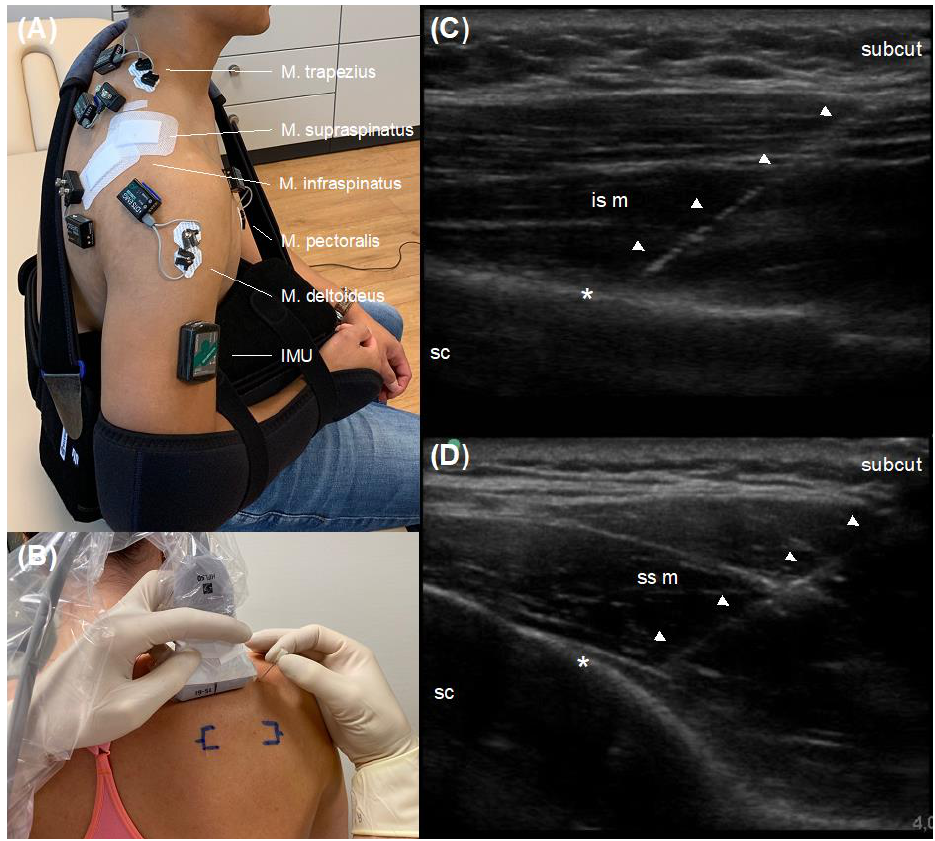
Figure 2. Placement of the electromyography electrodes on the investigated shoulder muscles. The placement of the inertial measurement unit is also shown. Note: ( A ) placement of electrodes and the inertial measurement unit (IMU); ( B ) sonography-guided application of the fine-wire electrodes; ( C ) positioning of electrode in the infraspinatus muscle; ( D ) positioning of electrode in the supraspina- tus muscle. Abbreviations: subcut = subcutaneous fat tissue; is m = infraspinatus muscle; sc = scapula; ss m = supraspinatus muscle; asterisk = cortical interface; arrows = intramuscular needle position. All EMG amplifiers and cables were fixed by double-sided adhesive tape and sterile patches (Figure 2). The EMG-data were acquired at 1500 Hz, processed using